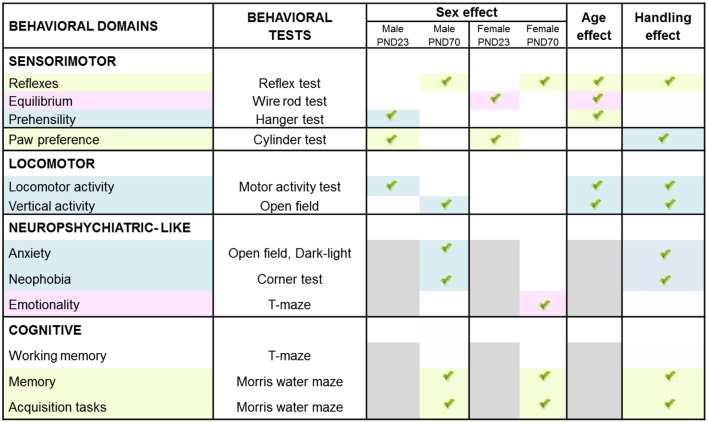
Graphical abstract of sex- age- and task-dependent behavior impact of HI brain injury and its modulation by handling.